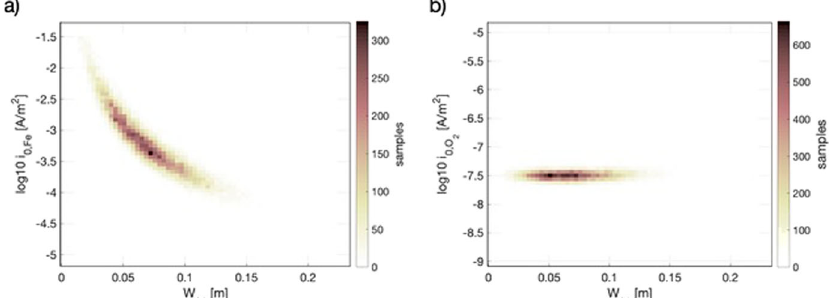
Fig. 7 2D histograms of the sampled model parameters. a The width of the anode versus log10( i 0,Fe ) versus the amount of samples. b The Þ versus the amount of samples. One sees a clear dependency between the size of the anode and the width of the anode versus log10 ð i 0 ; O 2 exchange current density for iron, while this dependency is not visible for the exchange current density of oxygen for